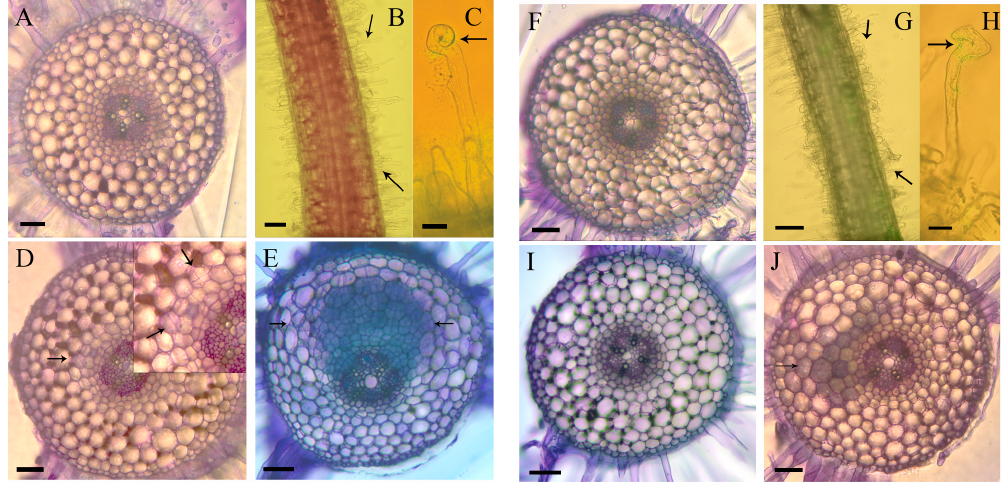
Figure 2. Effect of nitrate on nodulation phenotypes in M. trunatula . All pictures show roots or cross sections of roots at the inoculation site stained with Toluidine Blue. Panels A to E show roots grown in the absence of nitrate, panels F to J show roots grown on 2.5 mM nitrate-containing medium. ( A ) Uninoculated control root 24 h after mock-inoculation. No root hair curling or cell divisions are visible; ( B ) Root inoculated with S. meliloti 24 h p.i. shows a zone of curled and deformed root hairs (between arrows); ( C ) Magnification of a curled root hair, arrow points to the typical Shepard’s crook; ( D ) Root inoculated with S. meliloti 48 h p.i. showing the first inner cortical and pericycle cell divisions (arrow). The zone of cell division is enlarged in the insert panel; ( E ) Root inoculated with S. meliloti 120 h p.i. showing a developing nodule primordium (between arrows); ( F ) Nitrate treated control root 24 h after mock-inoculation; ( G ) Nitrate treated root 24 h p.i. with S. meliloti shows a zone of curled and deformed root hairs (between arrows); ( H ) Magnification of a curled root hair, arrow points to the typical Shepard’s crook; ( I ) Nitrate treated root inoculated with S. meliloti 48 h p.i.. No cortical or pericycle cell divisions are visible; ( J ) Nitrate treated root 120 h p.i. with S. meliloti showing very few inner cortical and pericycle divisions (arrow). Nine of ten roots at this time point showed no cell divisions. The magnification bars represent 100 µm in A , D , E , F , I and J; 400 µm in B and G ; 25 µm in C and H .